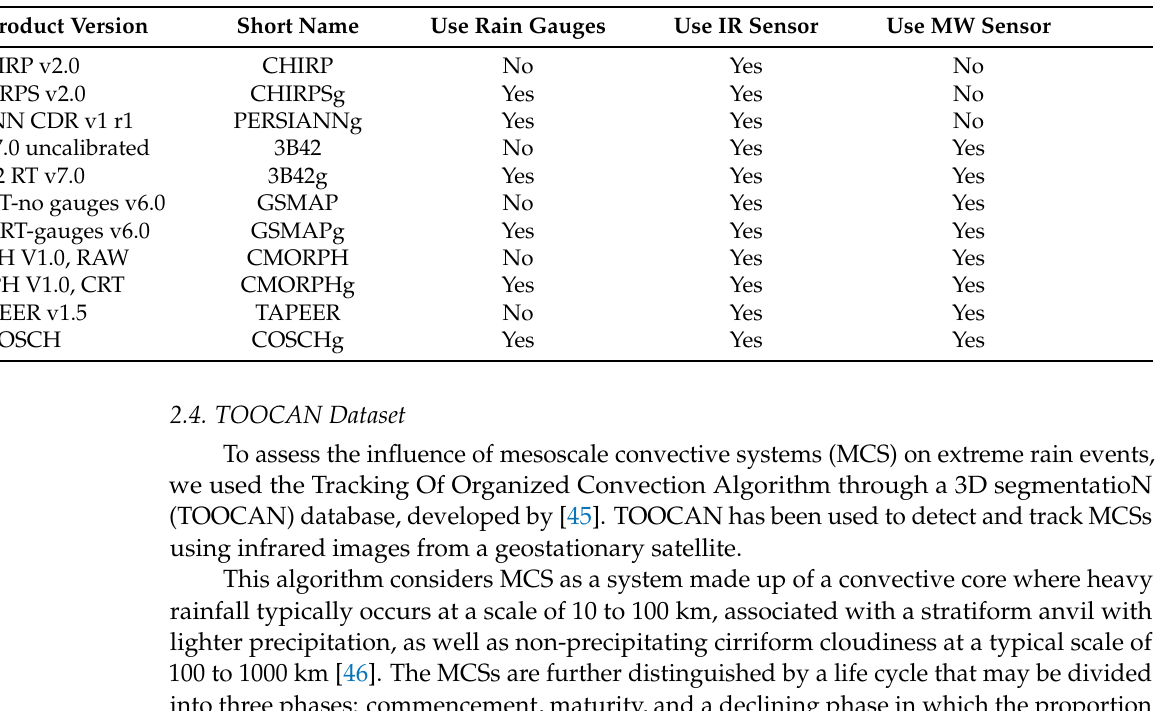
Table 1. Description of satellite products, adapted from